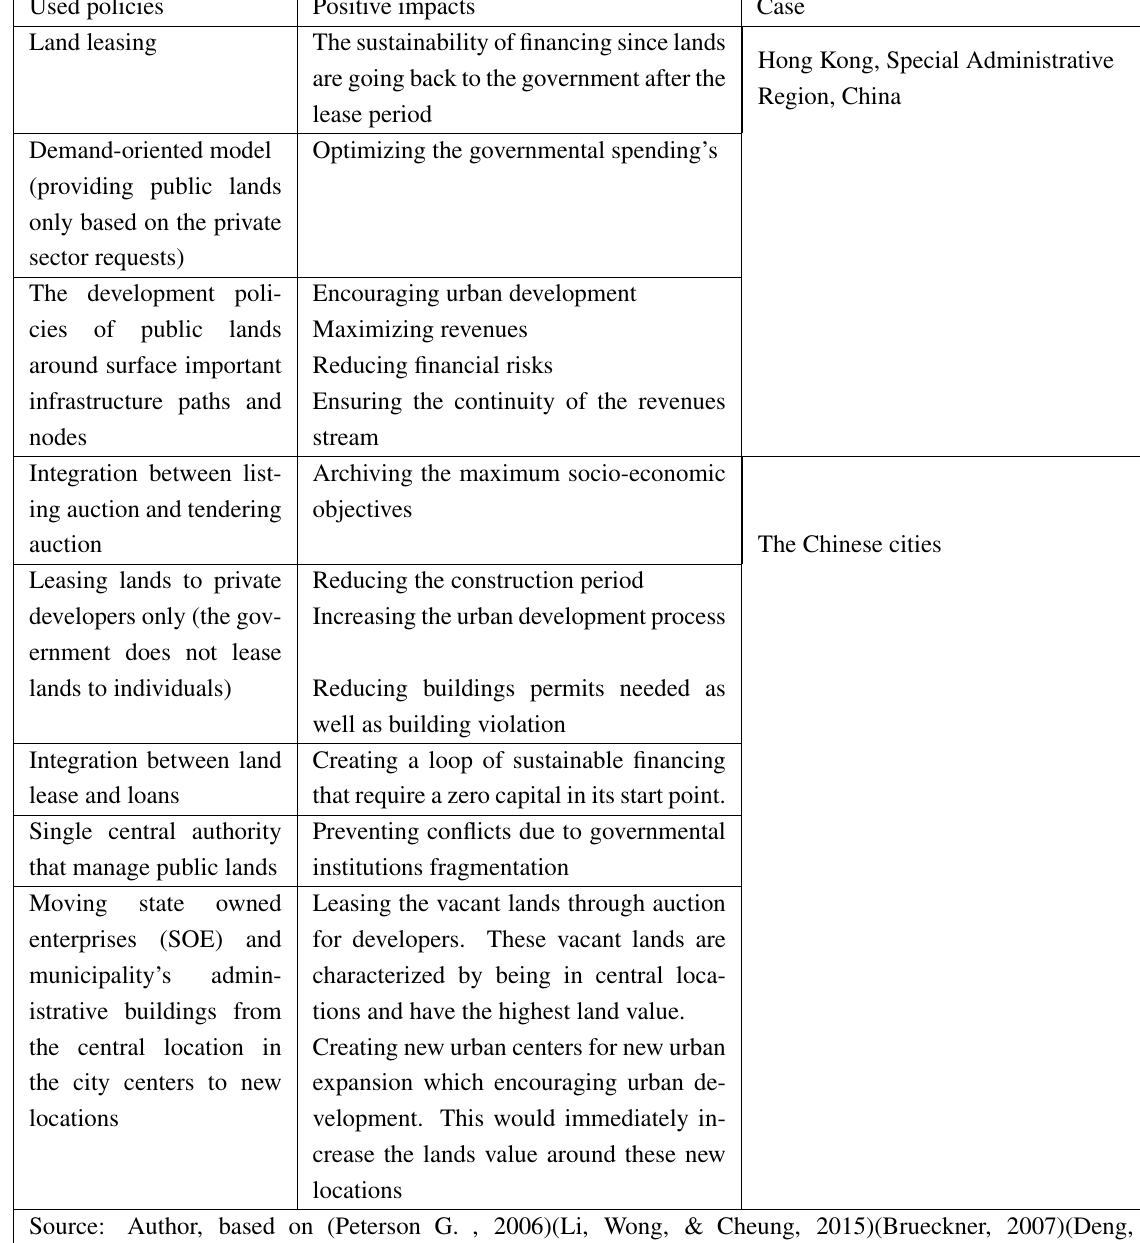
Table 4. Countries where governments use public lands as an asset for urban infrastructure